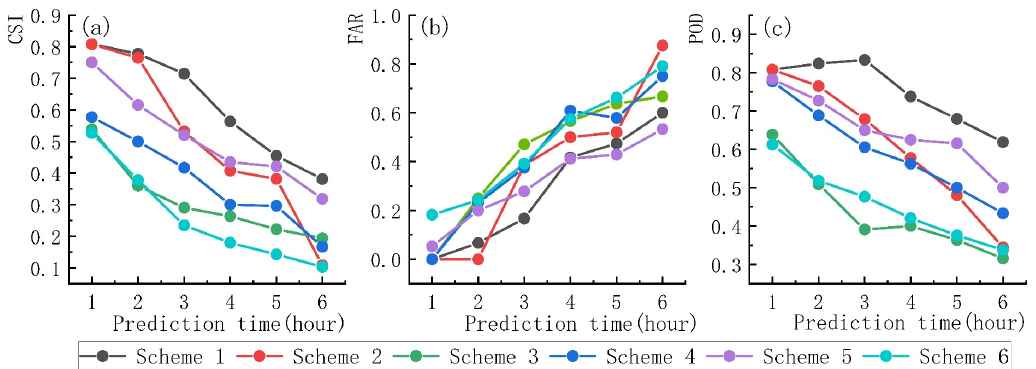
Figure 6. ( a ) CSI , ( b ) FAR , ( c ) POD of hourly rainfall forecast in Suyukou station when k =15.